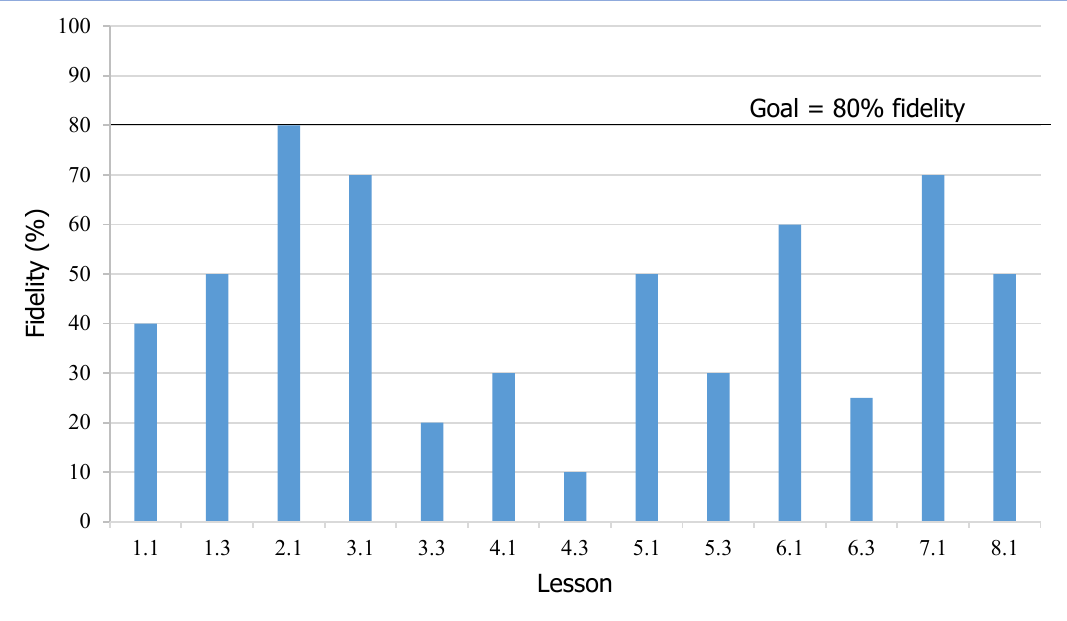
Figure 1. Fidelity to the Discovering Healthy Choices (Linnell et al., 2015) Curriculum by Lesson in the 1 st